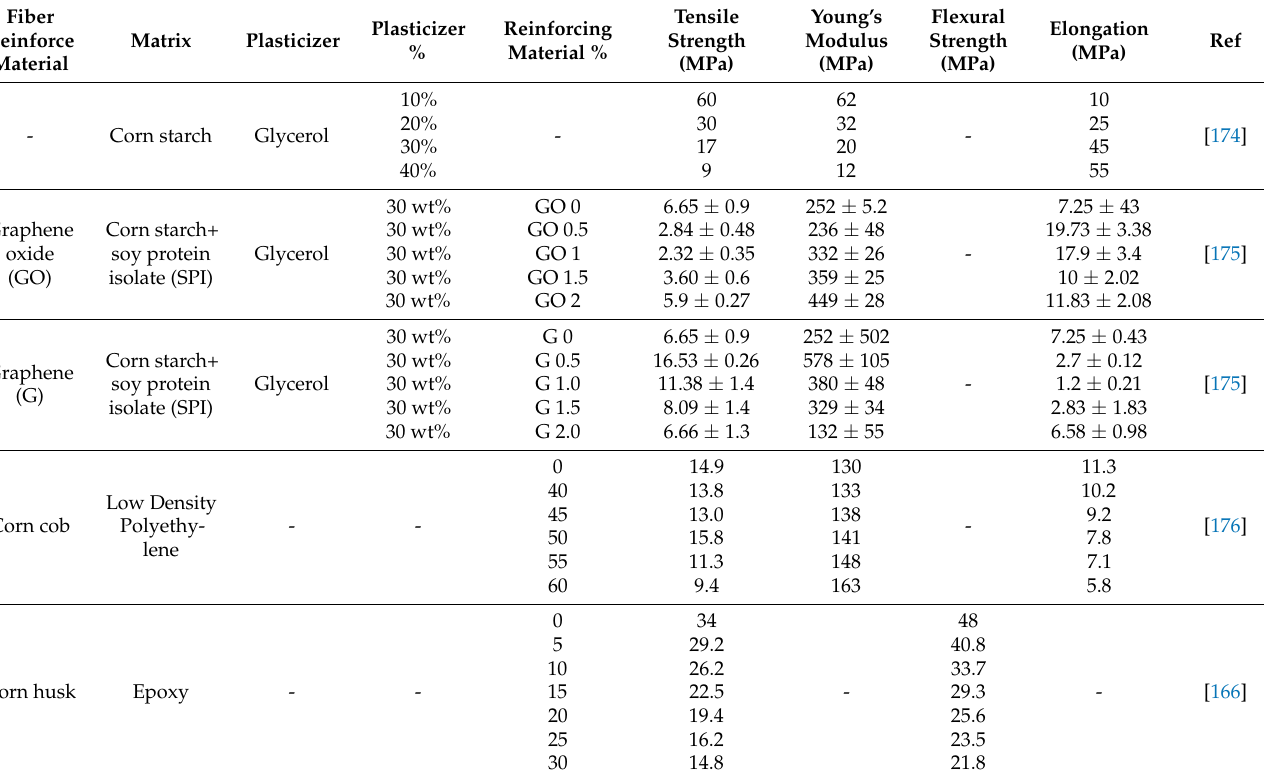
Table 4. Mechanical properties of corn based